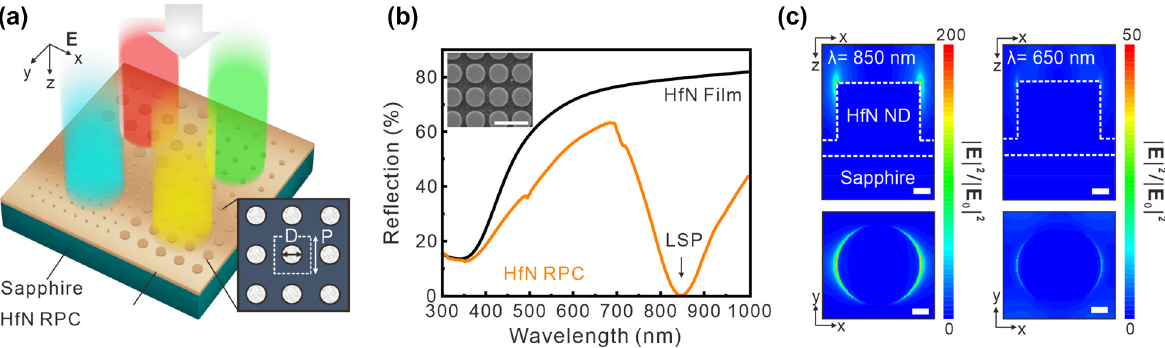
Figure 2: Plasmonic colors using a HfN refractory plasmonic crystals (RPCs). (a) Schematic of the plasmonic crystals that contain HfN nanodisk arrays on a 30 nm HfN back re fl ector. (b) Measured re fl ection spectra from the HfN RPC (orange) and HfN fi lm (black). The resonance dip in the re fl ection spectra at 850 nm originates from the LSPR. The inset shows an SEMimageoftheHfNRPC.TheunitcelloftheHfNNDhasdimensionsofpitch,diameter,andheightof P =700nm, D =520nm,and h =100nm. (c) Simulated electric fi eld intensity enhancement distributions in the x – z plane and x – y plane at λ = 850 nm (on resonance) and 650 nm (off